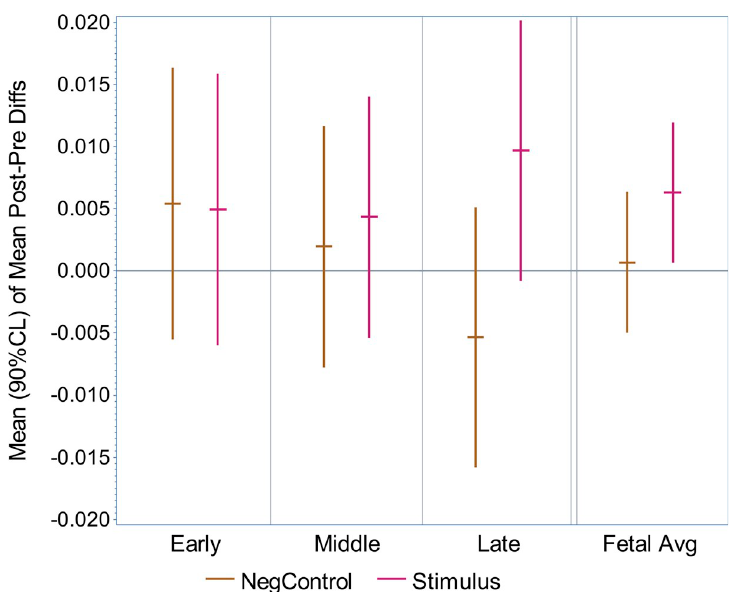
Fig 5. Subgroup analysis of gestational age. Summary of the statistical subgroup analysis depending on gestational age groups using a MF of 27 Hz. The error bars represent the 90% confidence intervals. Gestational age group 1 (‘early’), group 2 (‘middle’) and group 3 (‘late’) and their average (‘Fetal Avg’) are shown. Stimulation recordings (‘Stimulus’) and control recordings (‘NegControl’) are displayed.